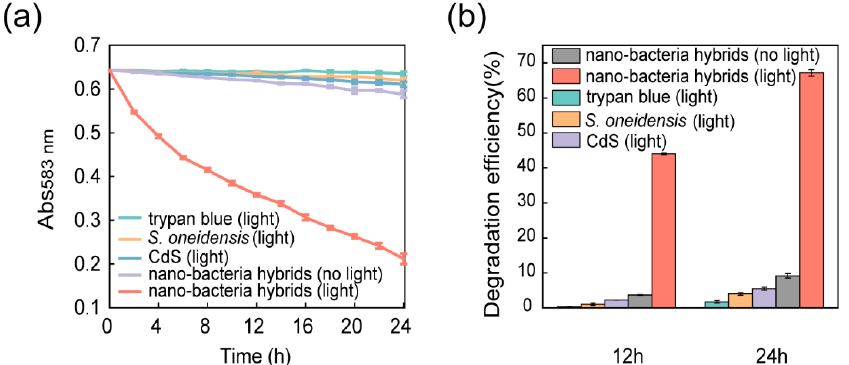
Figure 3. Photocatalytic degradation of trypan blue by nano-bacteria hybrids: ( a ) Change in concen- tration of trypan blue after treatment with nano-bacteria hybrids and controls. Nano-bacteria hybrids were incubated in a mineral medium solution containing 20 mg/L trypan blue and irradiated by a tungsten filament lamp. The absorbance of the reaction mixture at 583 nm was used to determine the change in concentration of trypan blue. Control groups included trypan blue only (with light), Shewanella oneidensis only (with light), CdS only (with light), and nano-bacteria hybrids (with- out light). The photocatalytic degradation performance of nano-bacteria hybrids was substantially improved compared to that of wild-type S. oneidensis cells; ( b ) The concentration of trypan blue after 12 h and 24 h of treatment was compared with the initial concentration to assess trypan blue degra- dation efficiency. The concentration was determined by comparing it to a trypan blue calibration curve generated based on Abs 583 nm . The photocatalytic degradation efficiency of nano-bacteria hy- brids was 33 times better than that of wild-type S. oneidensis cells. The data are presented as mean ± s.d ( n = 2).